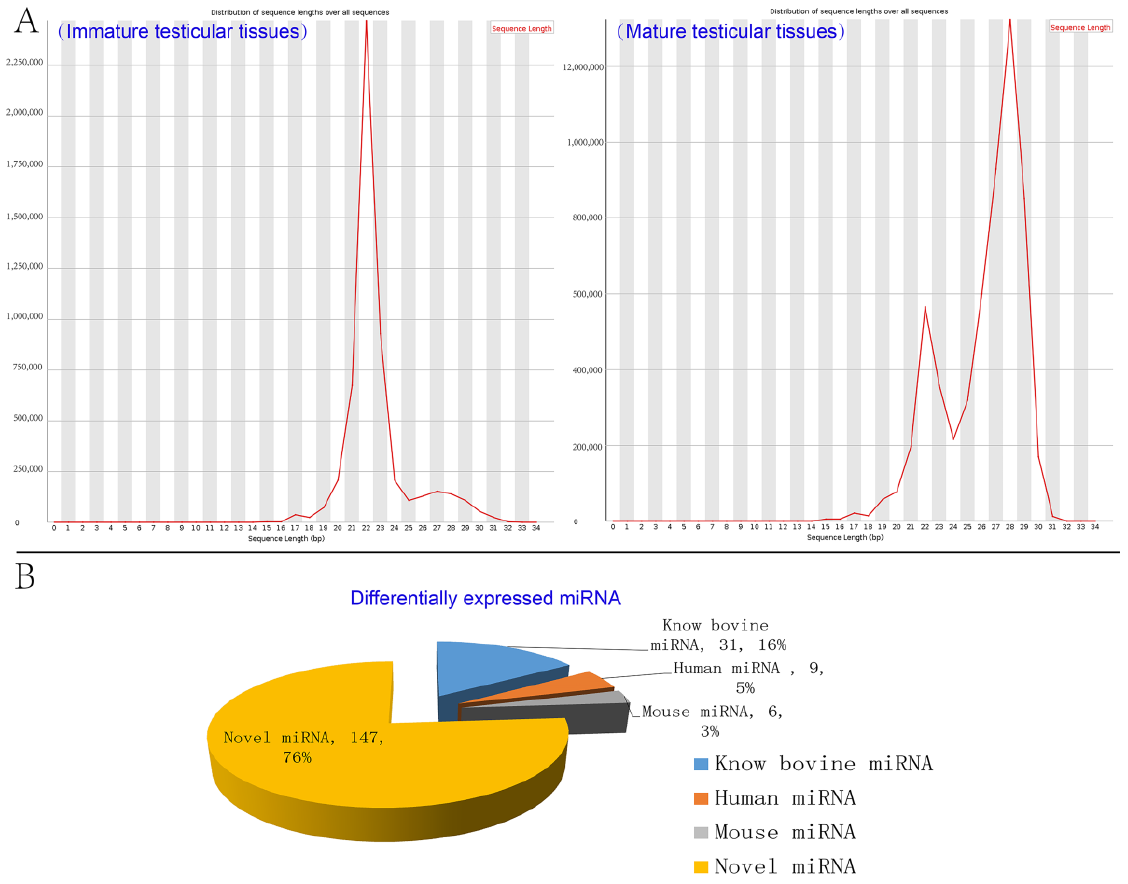
Figure 3. Analysis of miRNAs data by Solexa sequencing. ( A ) Length distribution of the clean reads; ( B ) Number and percentage of identified miRNAs. Table 2. Total of 31 differentially expressed miRNAs in the immature and mature testicular tissue.